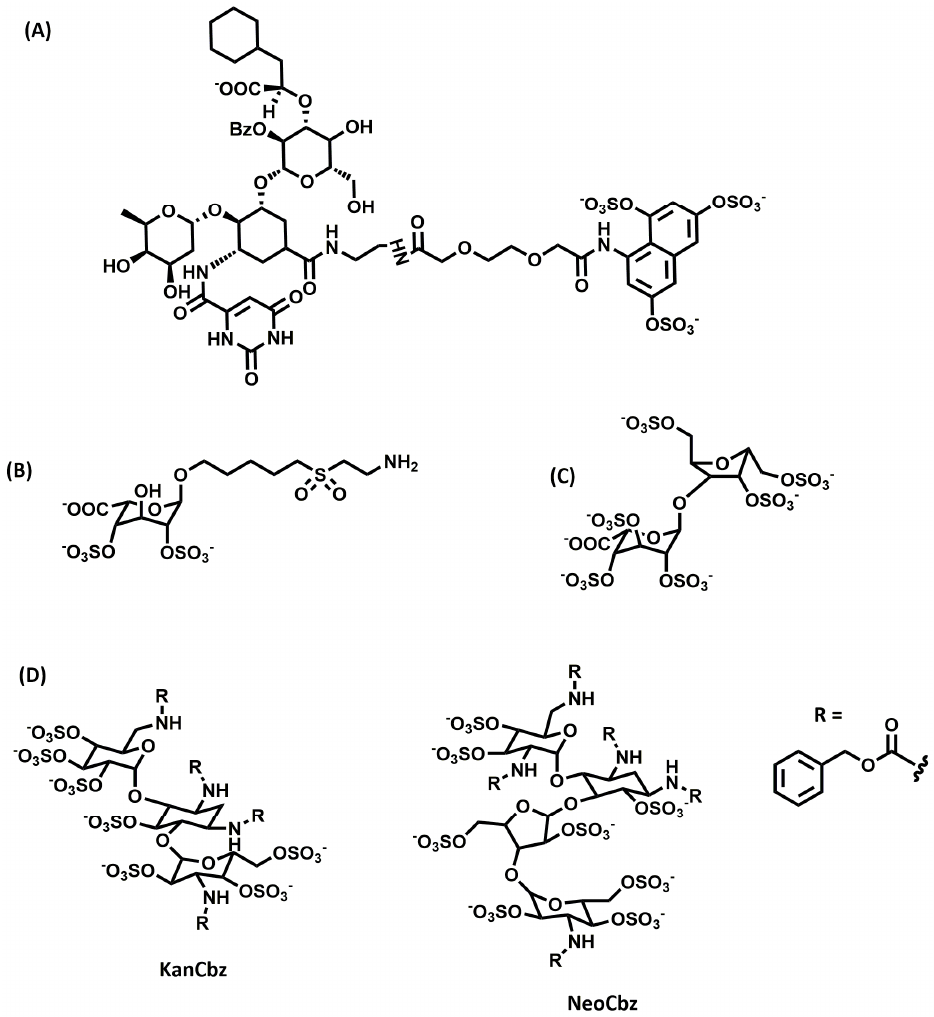
Figure5. Chemicalstructuresofsaccharideglycosaminoglycanmimeticsdevelopedasanti-inflammatory agents: ( A ) GMI-1070, ( B ) 2,4- O -di-sulfated iduronic acid (Di-S-IdoA), ( C ) Hep- super-sulfated disaccharide (SSD), and ( D ) KanCbz and